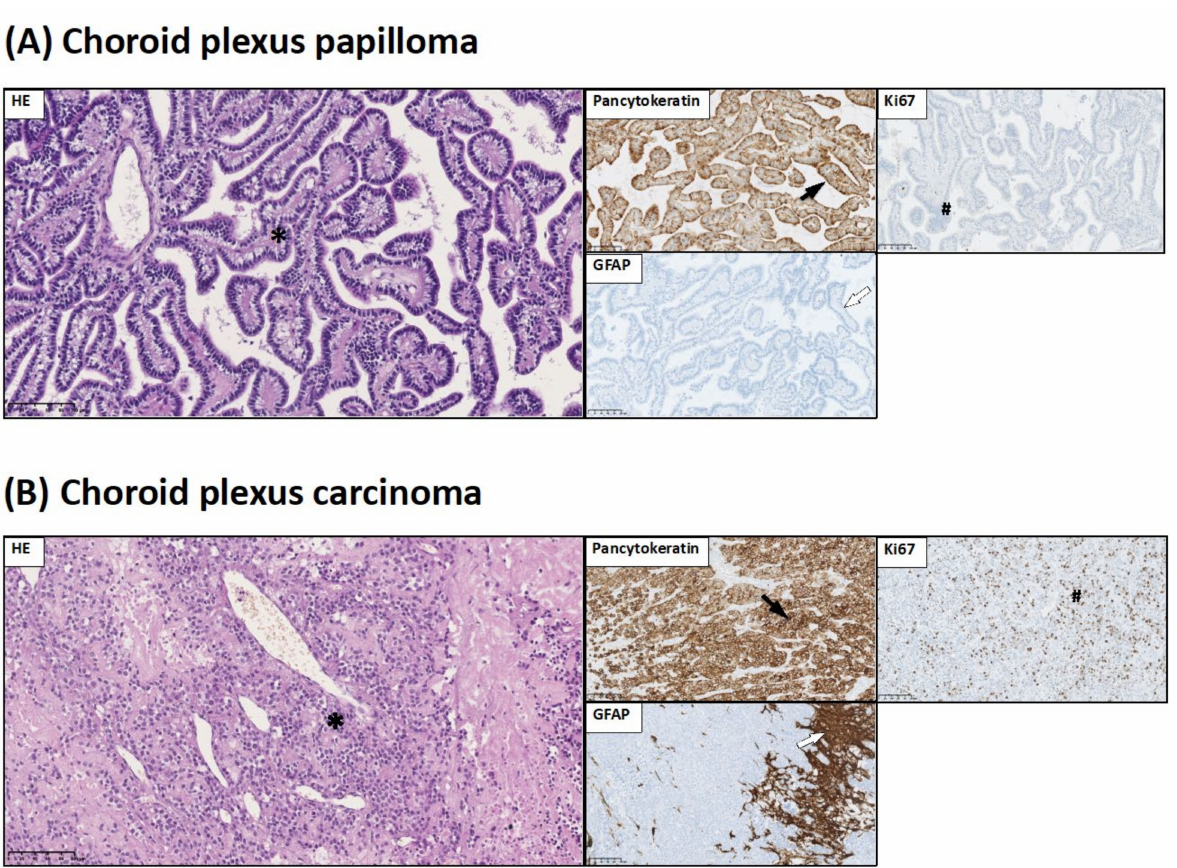
Figure 1. Histological and immunohistochemical staining of group 1 pediatric brain tumors: choroid plexus papilloma and choroid plexus carcinoma. HE staining as well as GFAP, Ki67, and pancytokeratin immunohistochemical staining were performed to visualize typical manifestations in these types of tumor tissue. ( A ) Choroid plexus papilloma (CPP): papillary pattern of CPP in HE staining (*). Neoplastic cells are positive for pancytokeratin immunostaining (black arrow). Low Ki67 LI in tumor tissue (#). GFAP negative staining in neoplastic cells (white arrow). ( B ) Choroid plexus carcinoma (CPC): solid pattern of CPC in HE staining (*). Neoplastic cells are positive for pancytokeratin immunostaining (black arrow). High Ki67 LI in tumor tissue (#). GFAP reactivity only in the parenchyma (white arrow). Preparations were scanned at original magnification 40 × , and digital magnification presented on the image was 20 × for HE and 10 × for immunohistochemical